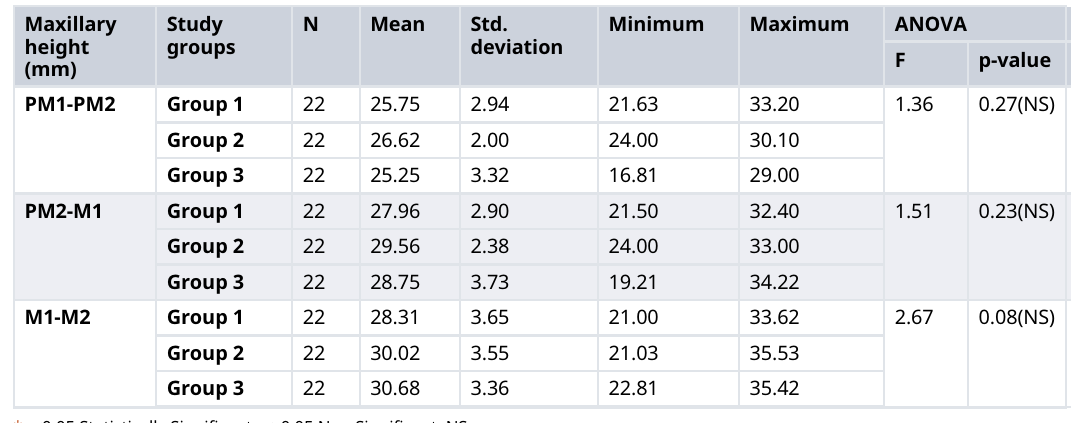
Table 1. Comparison of maxillary sinus height between the study groups.